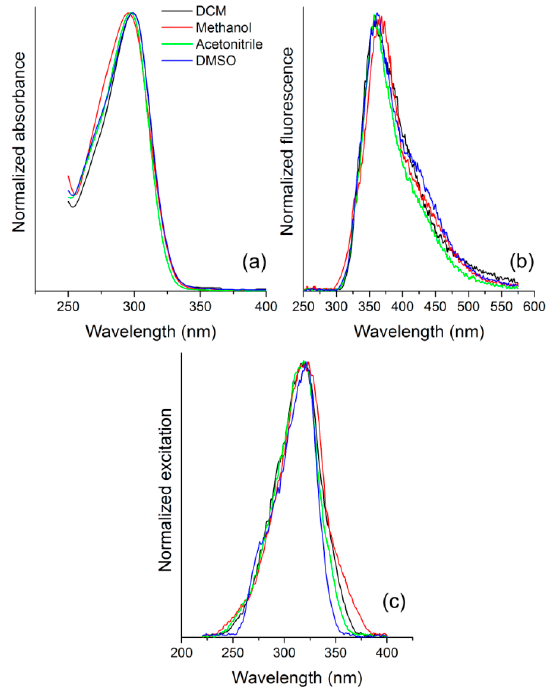
Figure 3. (a) UV-Vis absorption, (b) steady-state fluorescence emission, and (c) excitation spectra in solution of different organic solvents of spiropyran 7 [ca. 10 − 5 M] (DCM is dichloromethane, and DMSO is